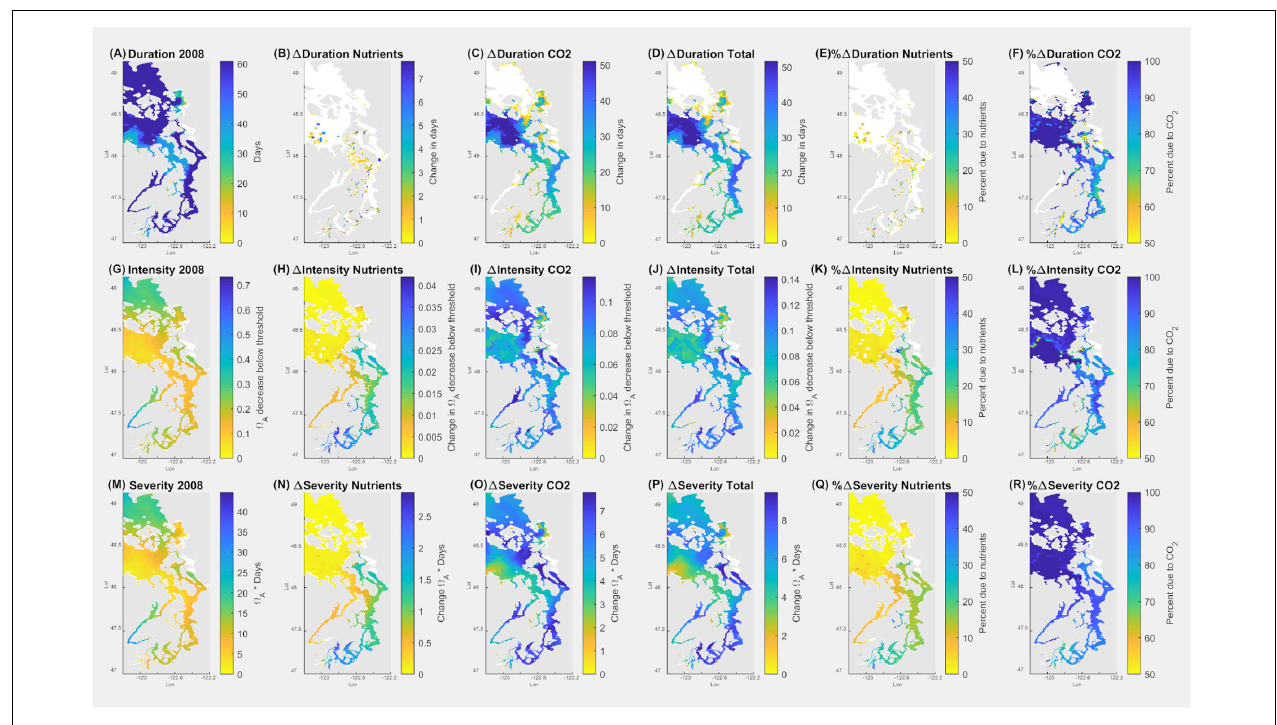
FIGURE 7 | Application of pteropod threshold for growth impairment (7 days at (cid:127) ar = 1.0) over the seasonal scale in the upper 100 m of the Salish Sea during September–October. Model outputs demonstrate current (2008) duration, intensity, and severity of the conditions (A,G,M) . The second column indicates the changes due to nutrients (B,H,N) ; the third column depicts the changes due to atmospheric CO 2 (C,I,O) ; the fourth column (D,J,P) shows total changes due to both nutrients and atmospheric CO 2 . The fifth column (E,K,Q) depicts % changes in (cid:127) ar due to nutrients, and the sixth column (F,L,R) is % change in (cid:127) ar due to atmospheric CO 2 . Values of zero are masked in